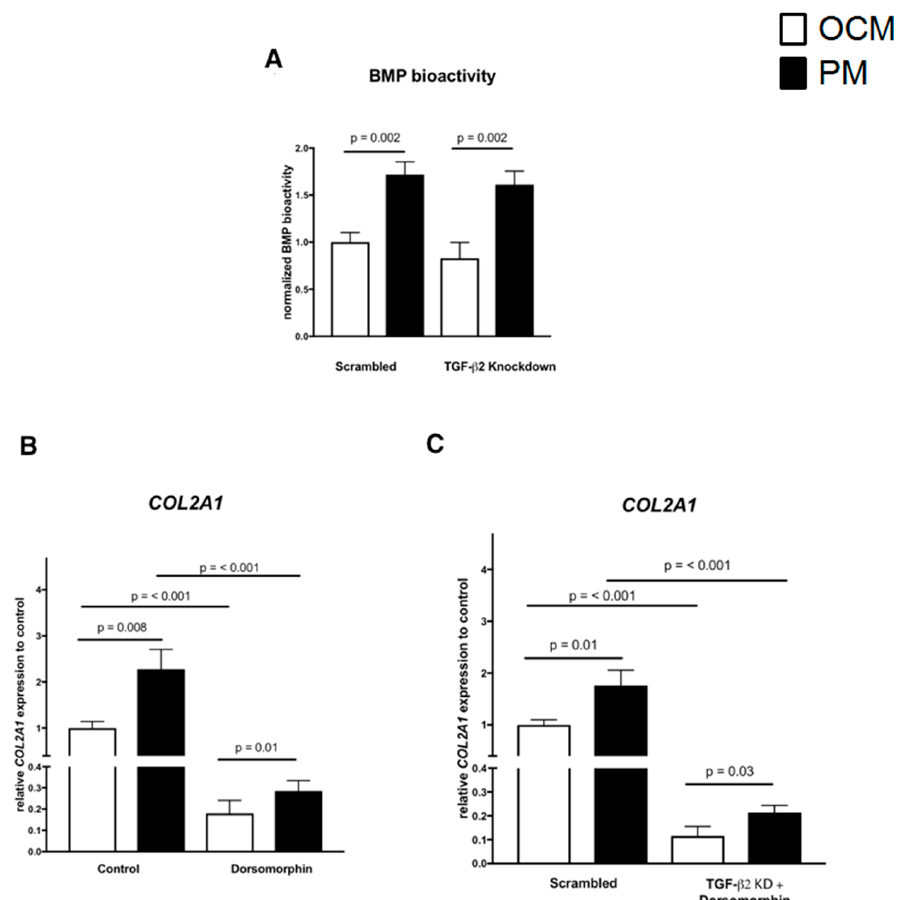
Figure 5. Blocking of BMP signalling decreases COL2A1 expression of chondrocytes irrespective of osmolarity. Bioassays in SW1353 cells show a largely TGF- β 2 knockdown-independent, but osmolarity-dependent induction of BMP-responsiveness. Data are the normalized means ± standard deviation (n = 3) relative to control OCM condition ( A ). Physosmolar conditions further significantly elevated COL2A1 expression as compared to vehicle controls at OCM ( B ). Dorsomorphin (10 µ M)-mediated inhibition of BMP signaling significantly suppressed COL2A1 expression in both osmolarities ( B ), but COL2A1 expression remained relatively higher in PM as compared to OCM irrespective of BMP signaling. Combining TGF- β 2 knockdown and dorsomorphin showed the same pattern as dorsomorphin alone ( C ). Data from five donors were measured in duplicates and are presented as normalized means ± standard deviation relative to control OCM condition. Data is normalized means ± standard relative to control OCM condition (replicate measurements, three donors).